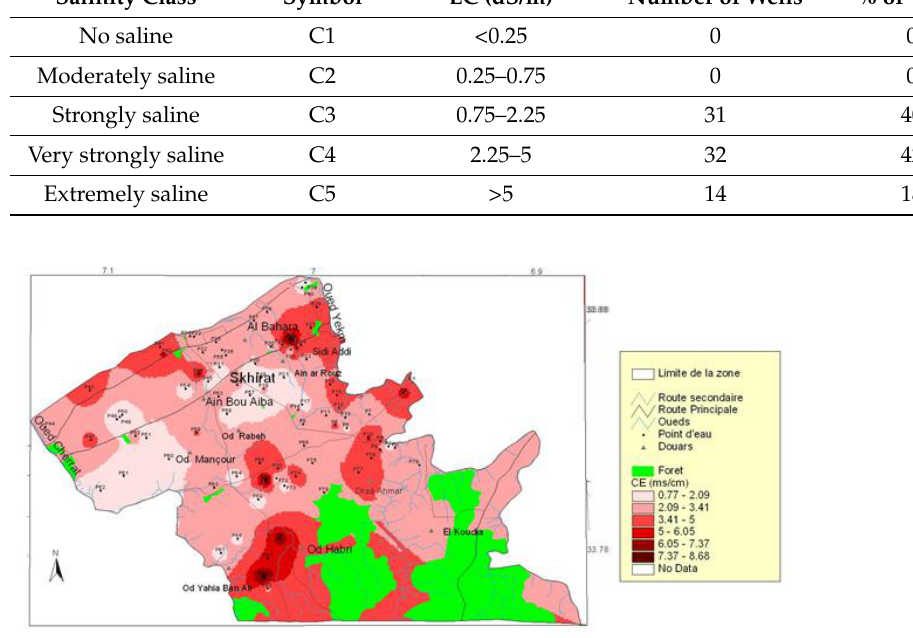
Figure 5. Groundwater salinity map from the Skhirat